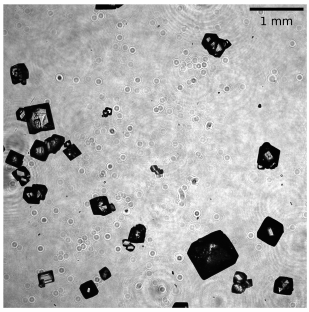
Figure 1. Exemplary image taken with the QICPIC equipped with LIXELL wet dispersing system of the model system